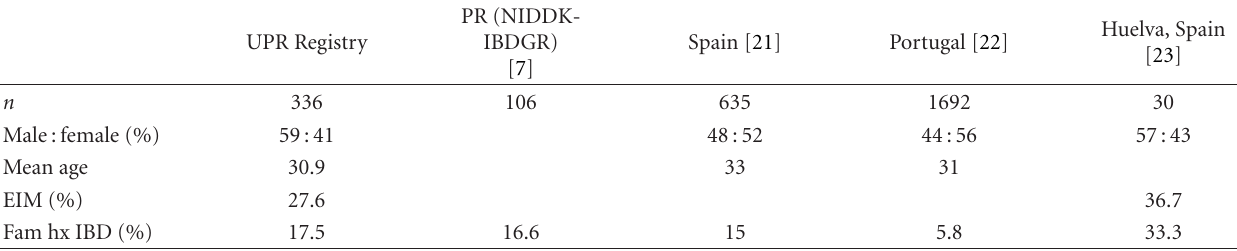
Table 3: Crohn’s disease: comparison with other Hispanic populations.